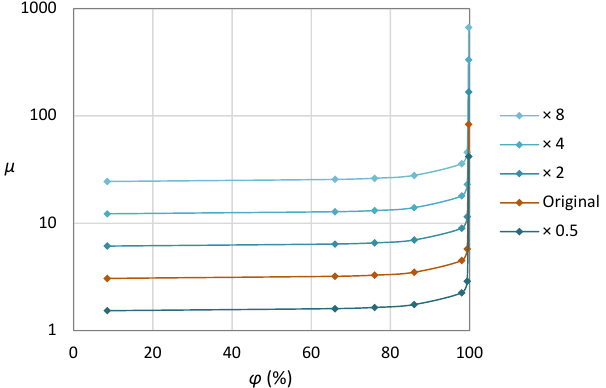
Figure 17. Vapor diffusion resistance factors µ estimated for Apulian limestone, as a function of relative humidity, examined in Section 3.6.2 for effects on intrinsic evaporative cooling (Figure